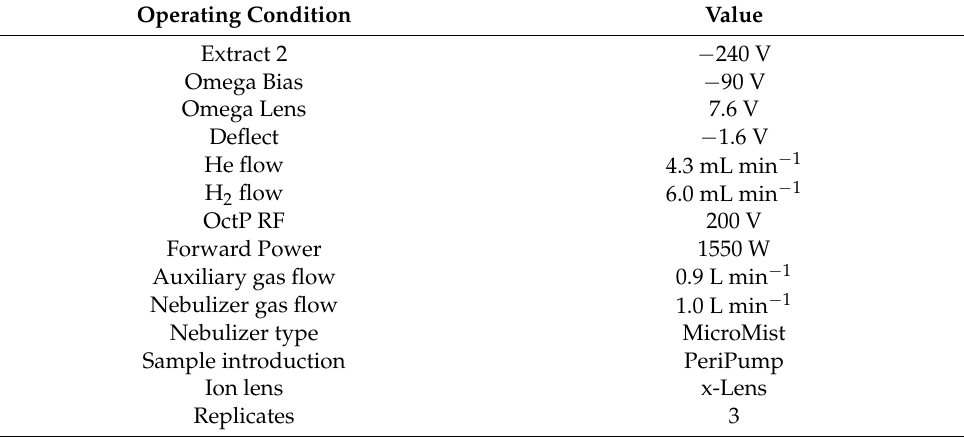
Table 2. ICP-MS operating conditions.